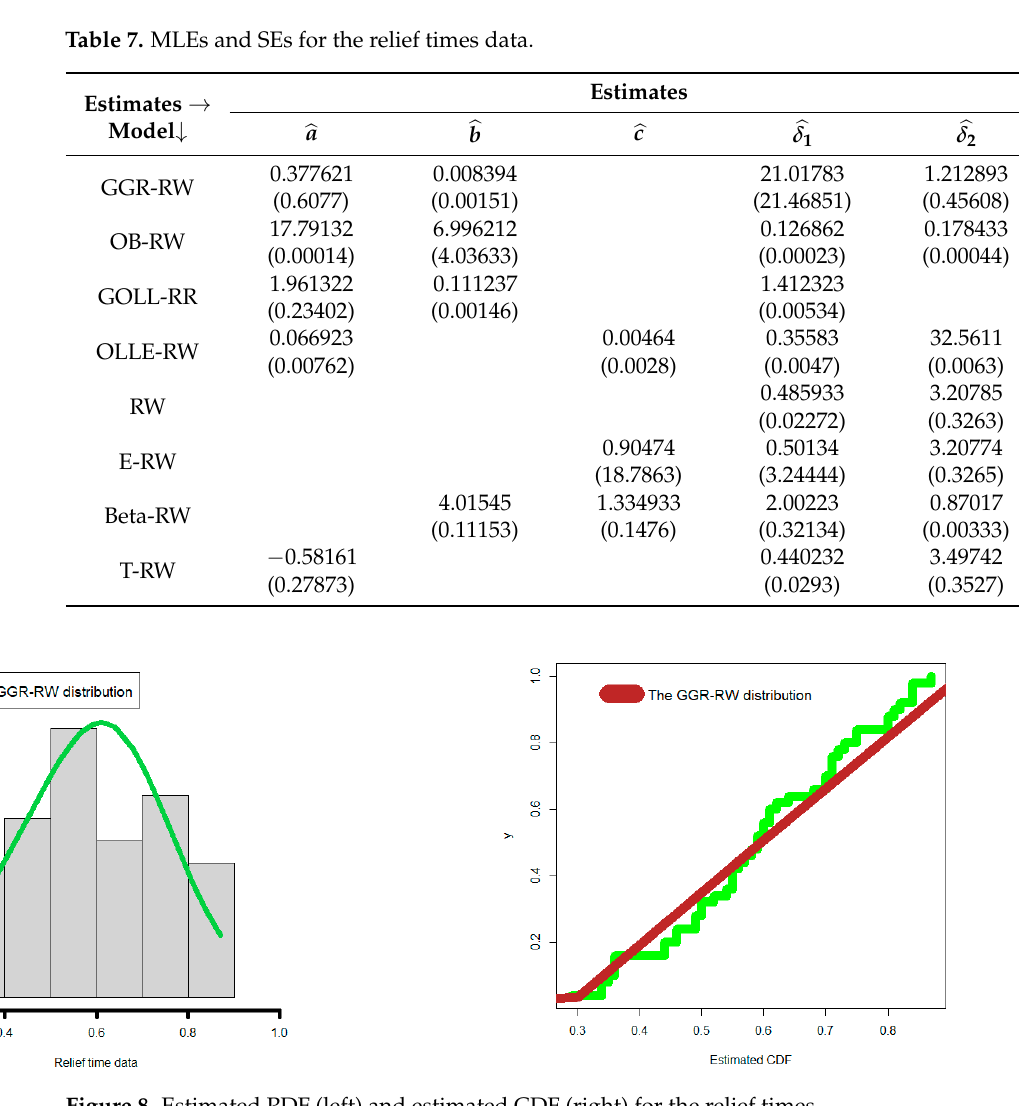
Figure 9. P-P panel (left) and estimated HRF (right) for the relief times. 5. Risk Analysis In this section, we will present a wide range of practical results, whether in the field of actuarial modeling or in the field of insurance applications. First, we introduce synthetic experiments to analyze actuarial risk. Secondly, we will conduct a comprehensive process study on insurance claims data. 5.1. Artificial Risk Analysis For risk analysis and evaluation, the maximum likelihood estimation (MLE), weighted least squares estimation (WLSQ), ordinary least squares estimation (OLSQ), and Cramér-von Mises estimation (CVME) methods are considered. We will ignore the alge- braic derivations and theoretical results of these methods since it is already present in a lot of statistical literature. On the other hand, we will focus a lot on the practical results and statistical applications of mathematical modeling in general and of the risk disclosure, analysis risk, and evaluation of actuarial risks. For computing the above-mentioned KRIs, the following estimation techniques are discussed in these sections: the MLE, OLSQ, WLSQ and CVME methods. Seven CLs (q = 50%,60%,70%,80%,90%,95%,99% and 99%) and N = 1000 with Various sample sizes (n = 20,50,100) are considered under 𝛼 (cid:2868) = 2, 𝑏 =